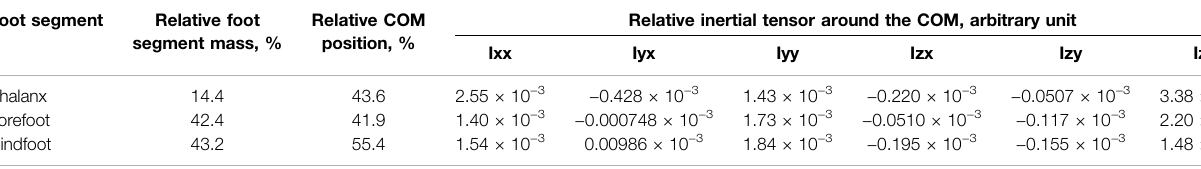
TABLE 3 | Relative segment mass, relative center of mass position, and relative inertial tensor around the center of mass of each phalanx, forefoot, and hindfoot segment.